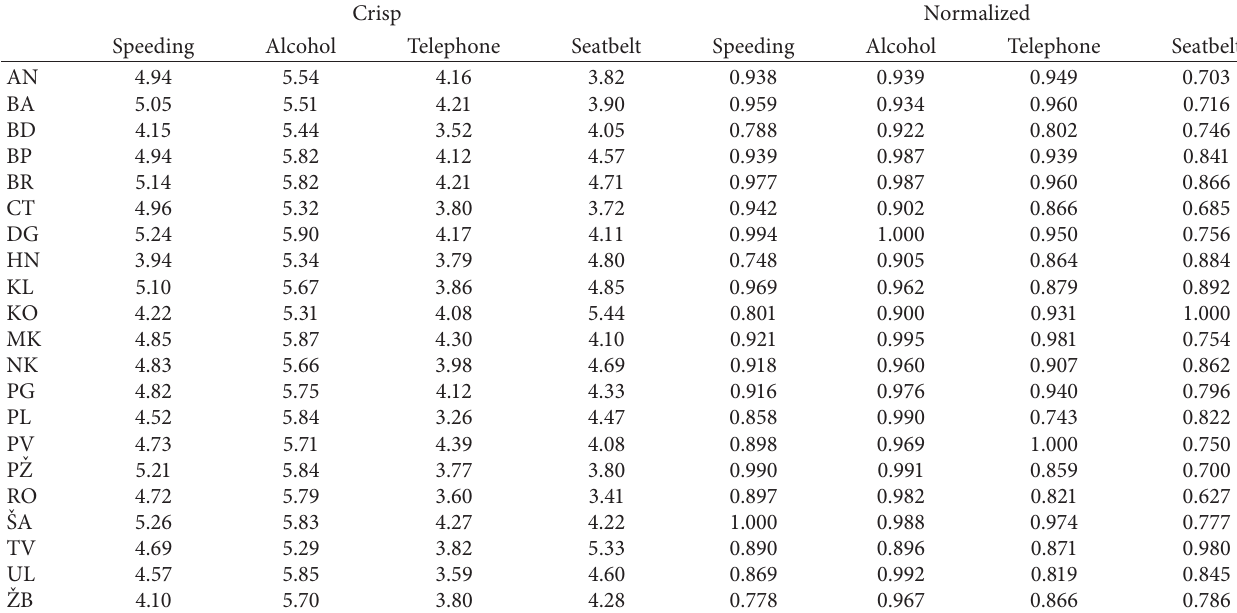
Table 9: Final crisp behavior